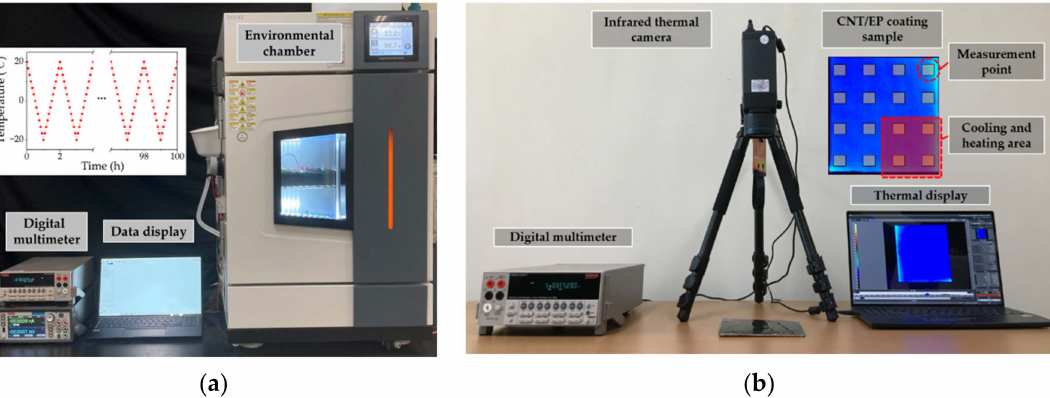
Figure 2. Temperature sensing performance equipment and details: ( a ) static and cycle sensing test; ( b ) multi-sensing